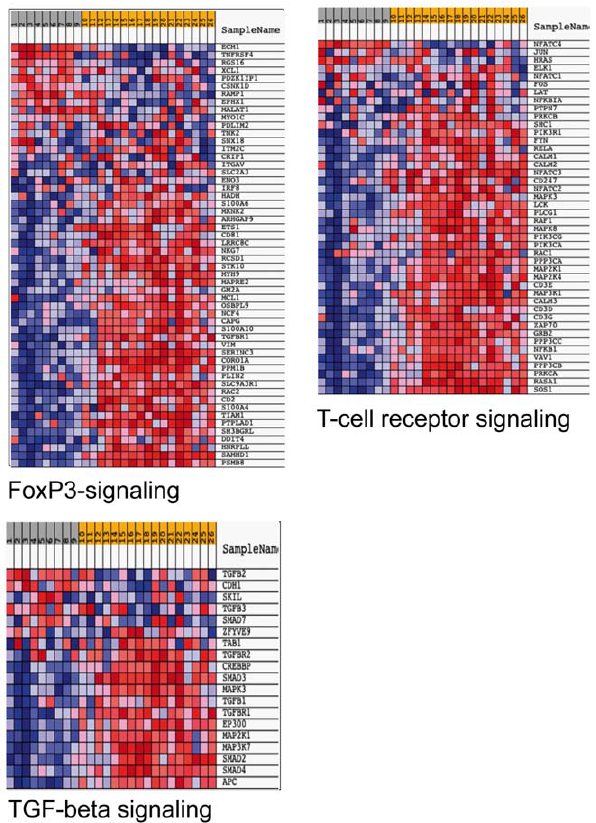
Figure 2. Comparison of gene expression of PBLs of mRCC patients and healthy controls following normalization of microarray expression data. Gene Set Enrichment Analysis (GSEA) was performed for 17 mRCC patients PRE (yellow background, # 10–26) vs. 9 healthy controls (grey background, # 1–9). GSEA uses a Kolmogorov Smirnov statistic to explore unique gene signature of small groups of genes within a data set. Shown are representative pathways that were up-regulated in the mRCC samples (p , 0.05).